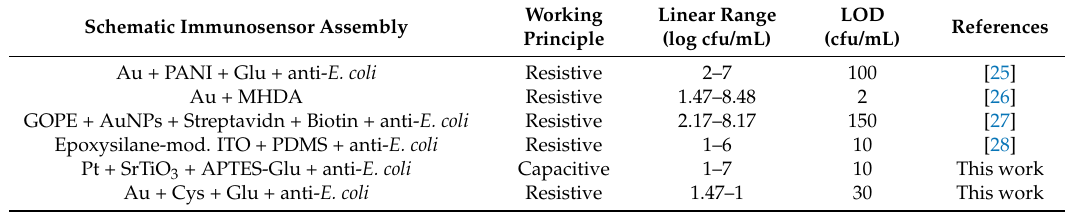
Table 2. Comparison among impedimetric label-free Escherichia coli O157:H7